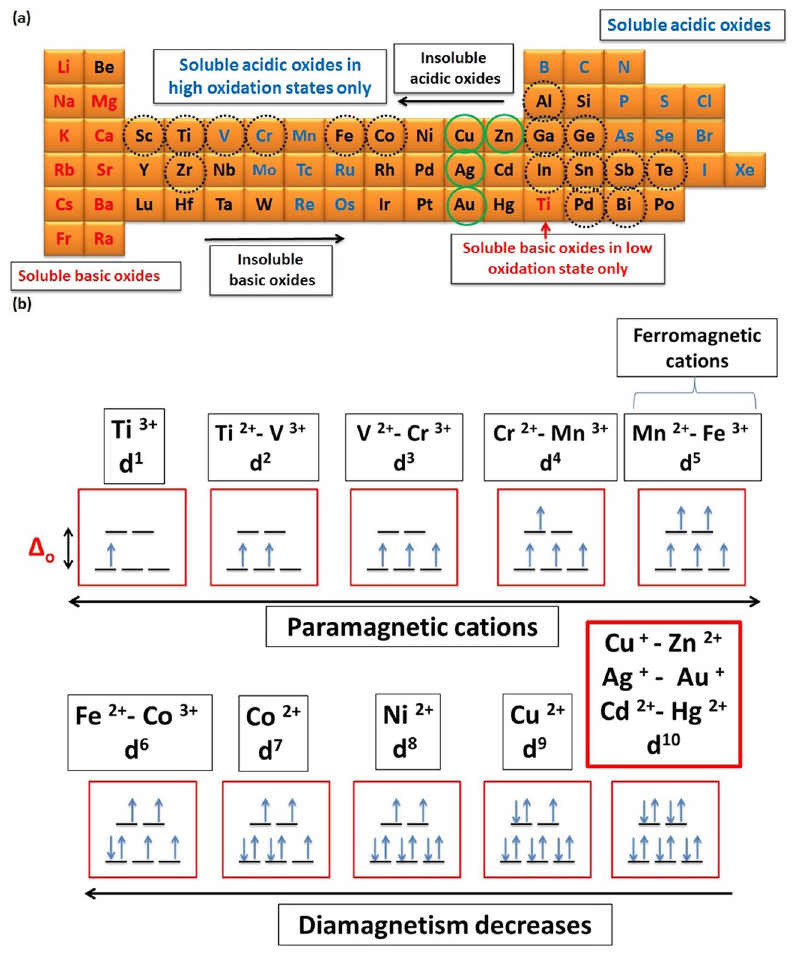
Figure 25. Amphoteric, acidic and basic oxides (doted-circled elements indicate the amphoteric oxides – green circled elements indicate the ideal amphoteric oxides according to ATMTE on the basis of theoretical predictions) ( a ), and magnetic properties of some transition metal cations ( b